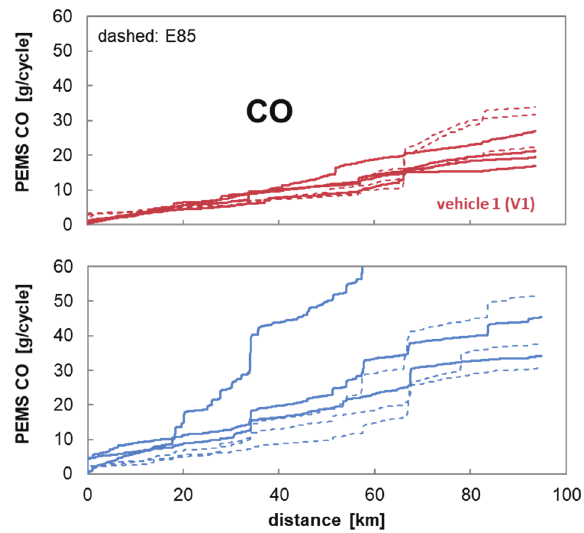
Fig. 6. PN – Emissions during RDE urban part with E0 and E85; Volvo (V1); Audi (V2)